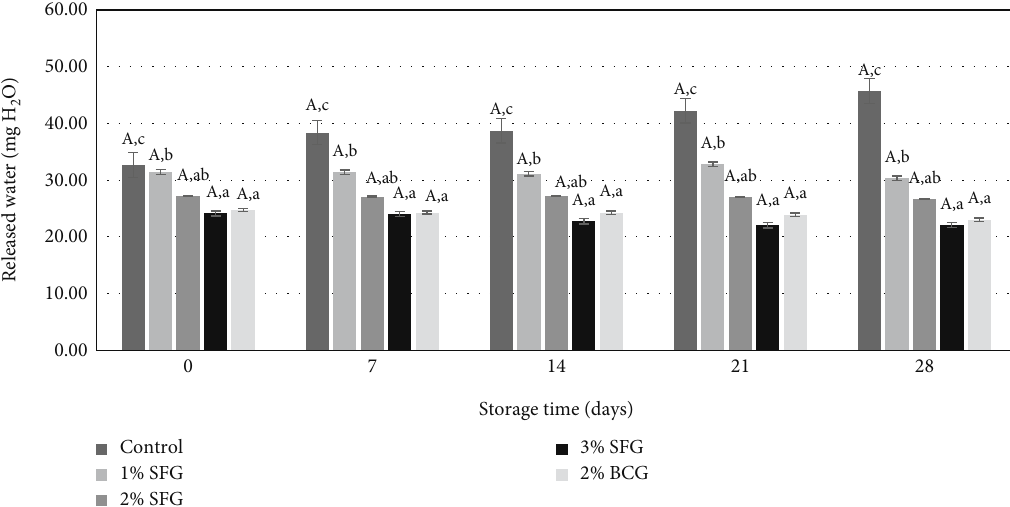
Figure 2: The addition of gelatin level and storage time to the released water (mg H di ff erences in storage time ( p < 0 : 05 ), and lowercase letters indicate di ff erences with level gelatin ( p < 0 : 05